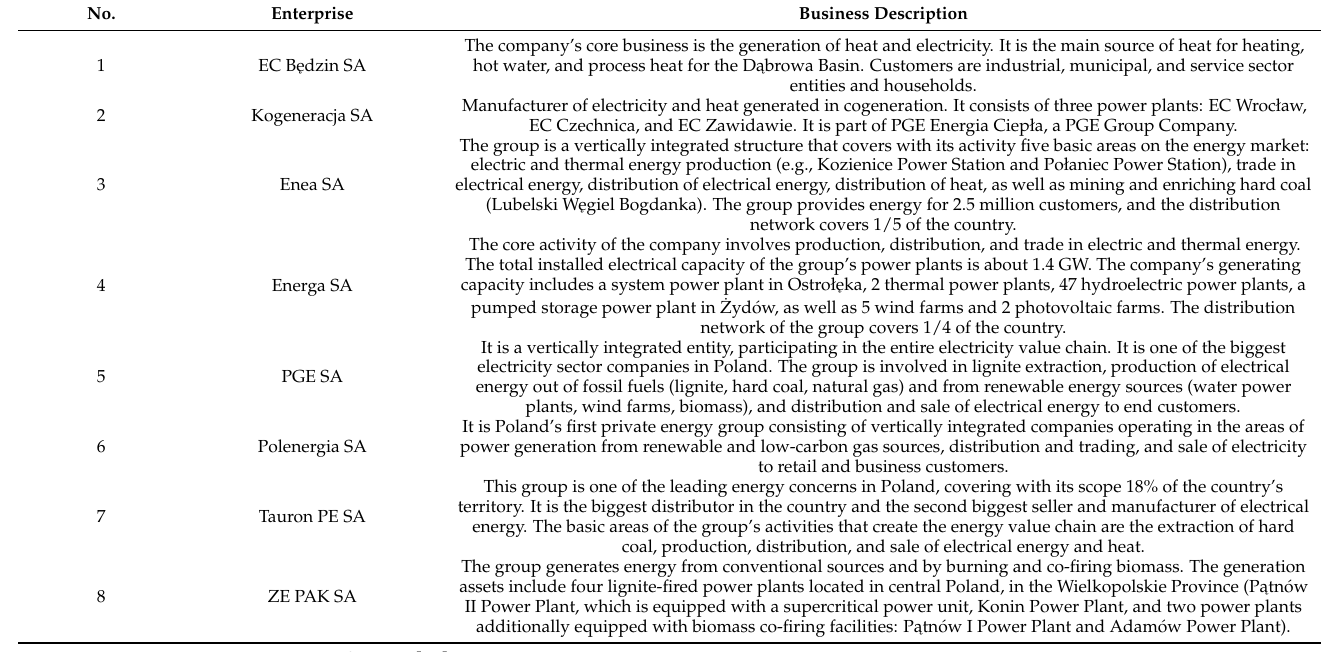
Table 1. The characteristics of the researched energy